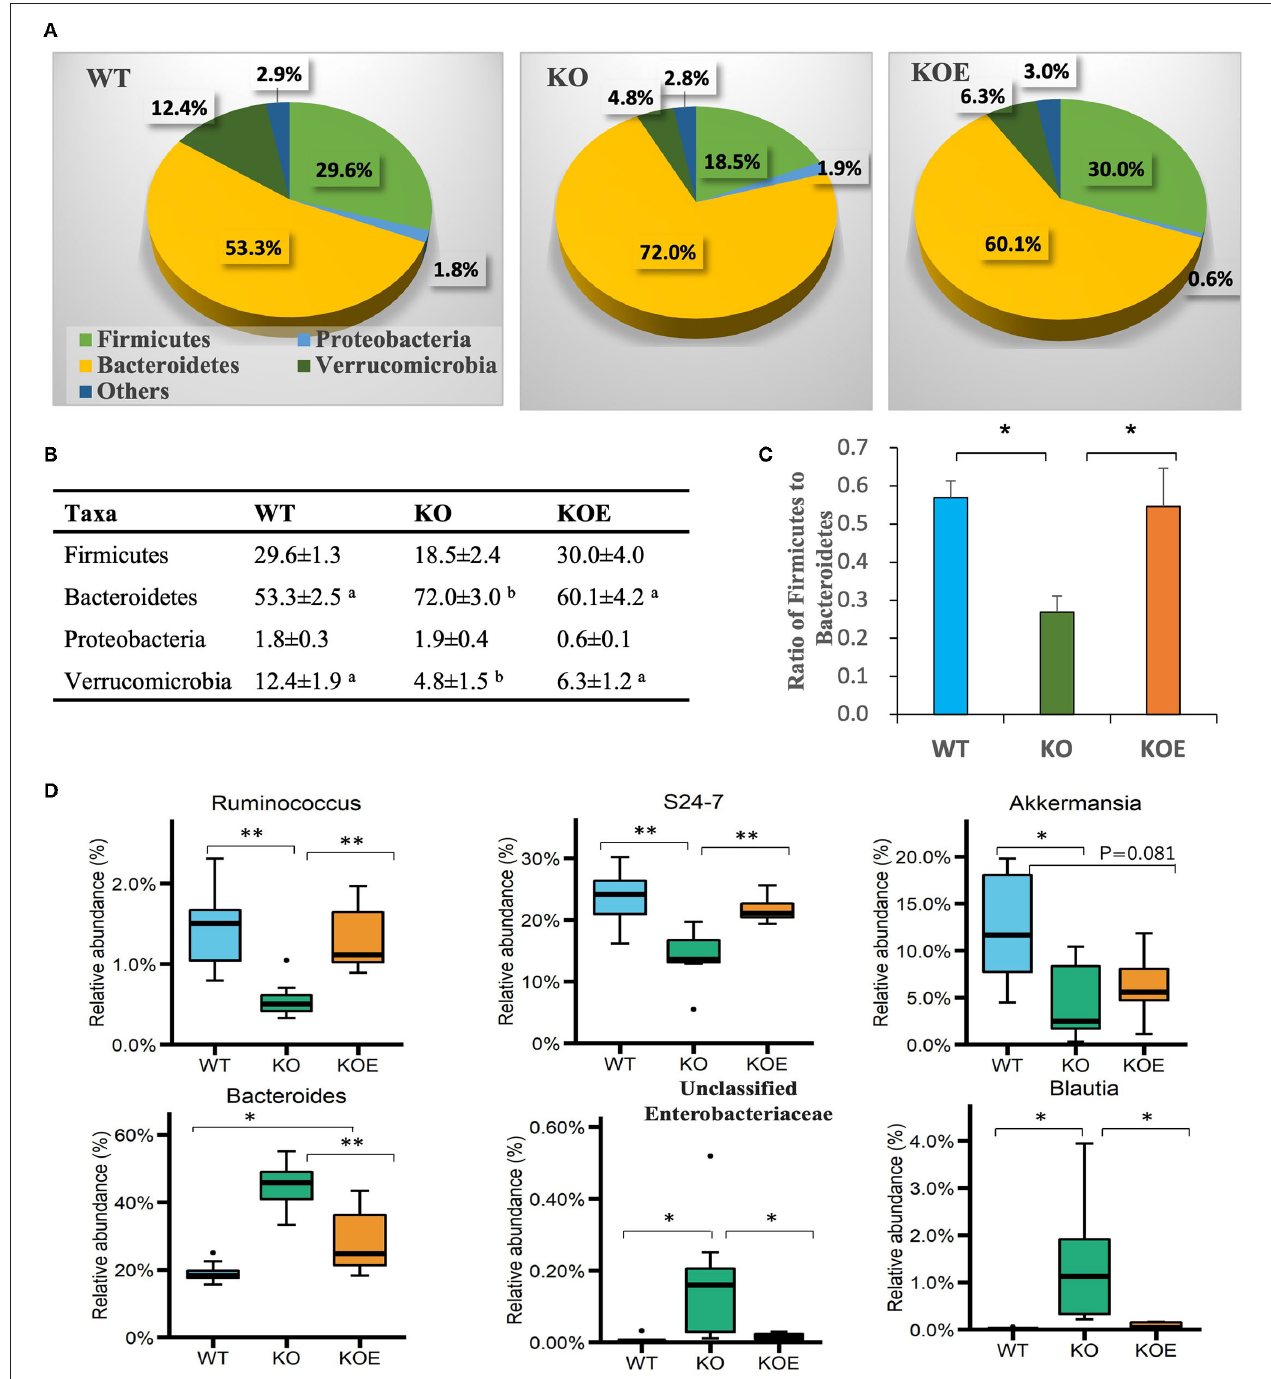
FIGURE 3 | Effect of eggshell membrane (ESM) on gut bacterial composition in IL10 − / − (KO) mice [wild-type (WT): n = 8, KO and KO with ESM supplementation (KOE): n = 7, respectively]. Relative abundance of phyla is demonstrated in the pie graphs (A) and table (B) . (C) The ratio of Firmicutes to Bacteroidetes in the three groups. (D) The abundance of gut bacterial taxa at the genus level. Different superscript letters indicate significant differences at P < 0.05. * P < 0.05, ** P < 0.01. The dots (•) in the boxplots indicate outliers.